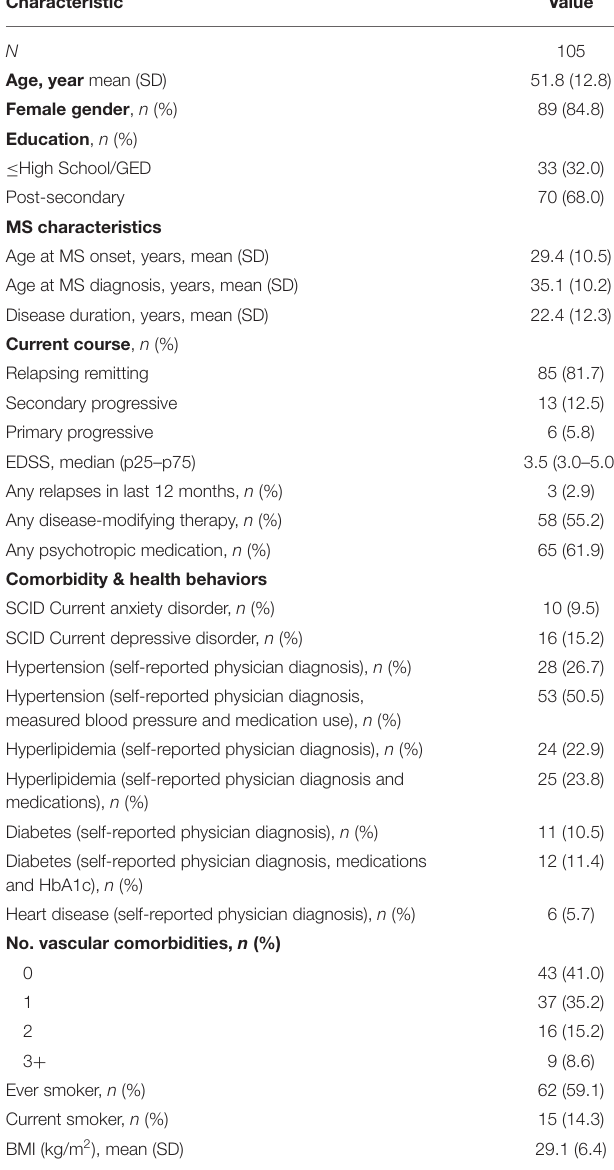
TABLE 1 | Cohort demographic and clinical